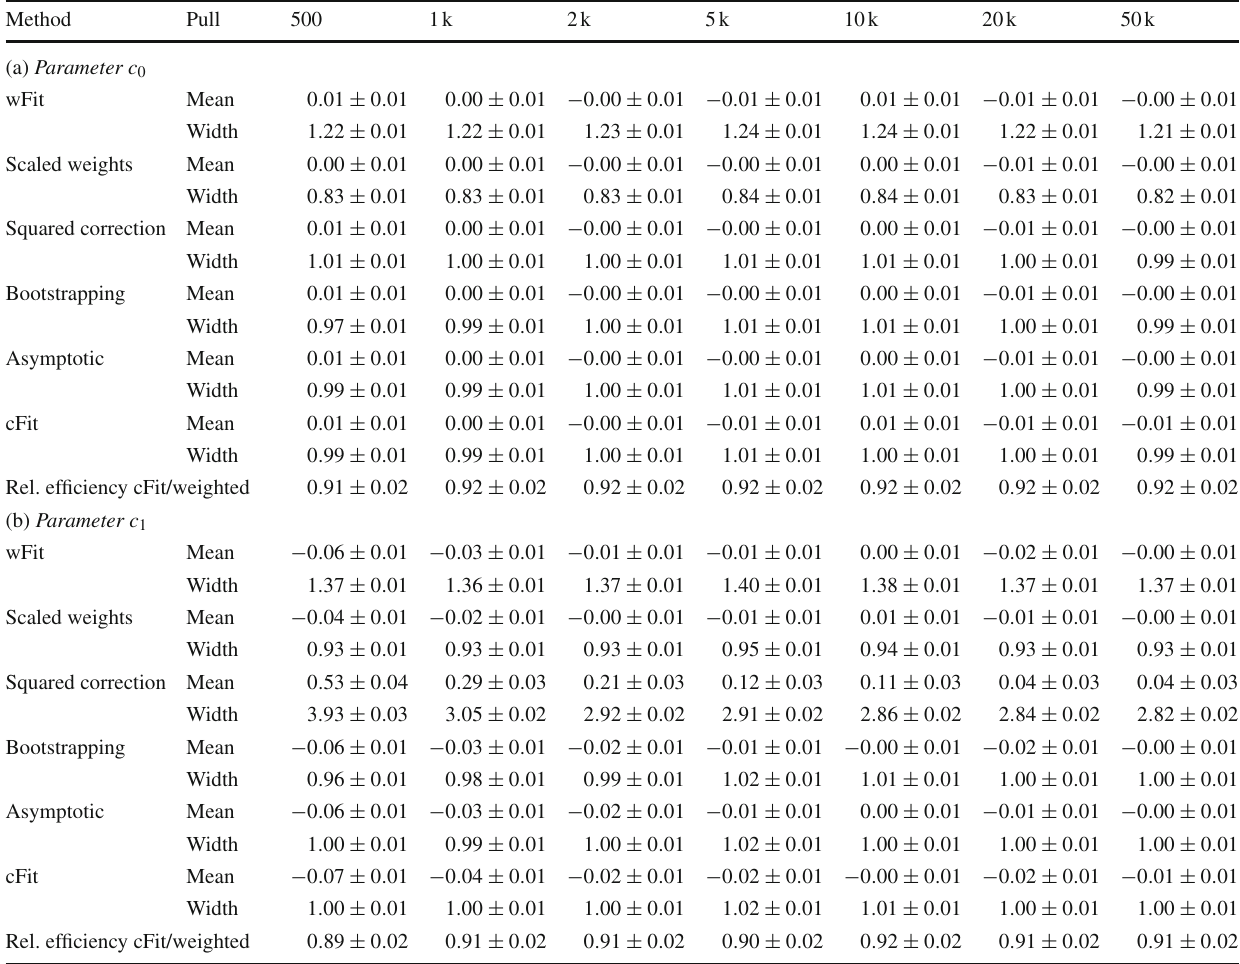
Table 3 Means and widths of the pull distribution for the different approaches to the uncertainty estimation for the efficiency correction (cid:4)( cos θ) = 0 . 3 + 0 . 7cos 2 θ , depending on the number of events. In